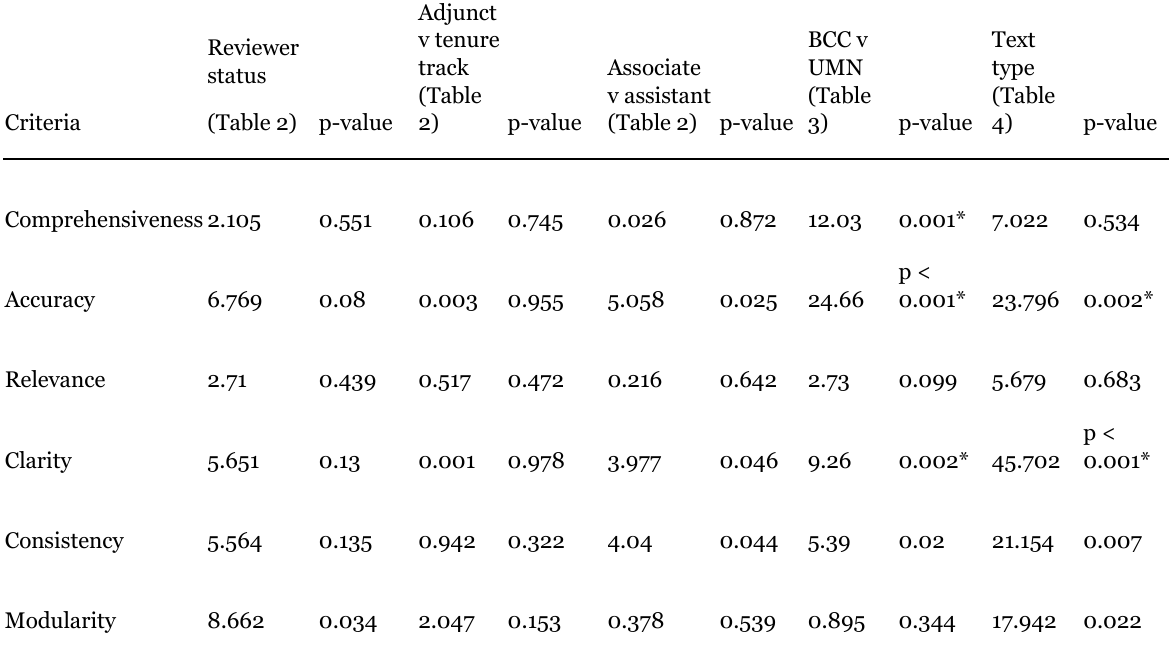
Summary of Kruskal-Wallis Tests of Differences Across Groups in Terms of 10 Criteria